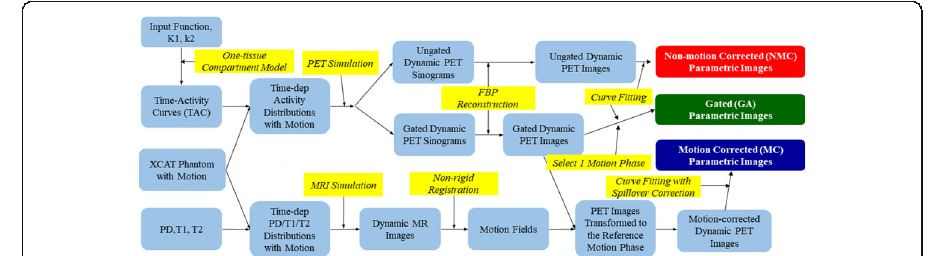
Fig. 1 Flowchart of PET-MR data simulation and processing